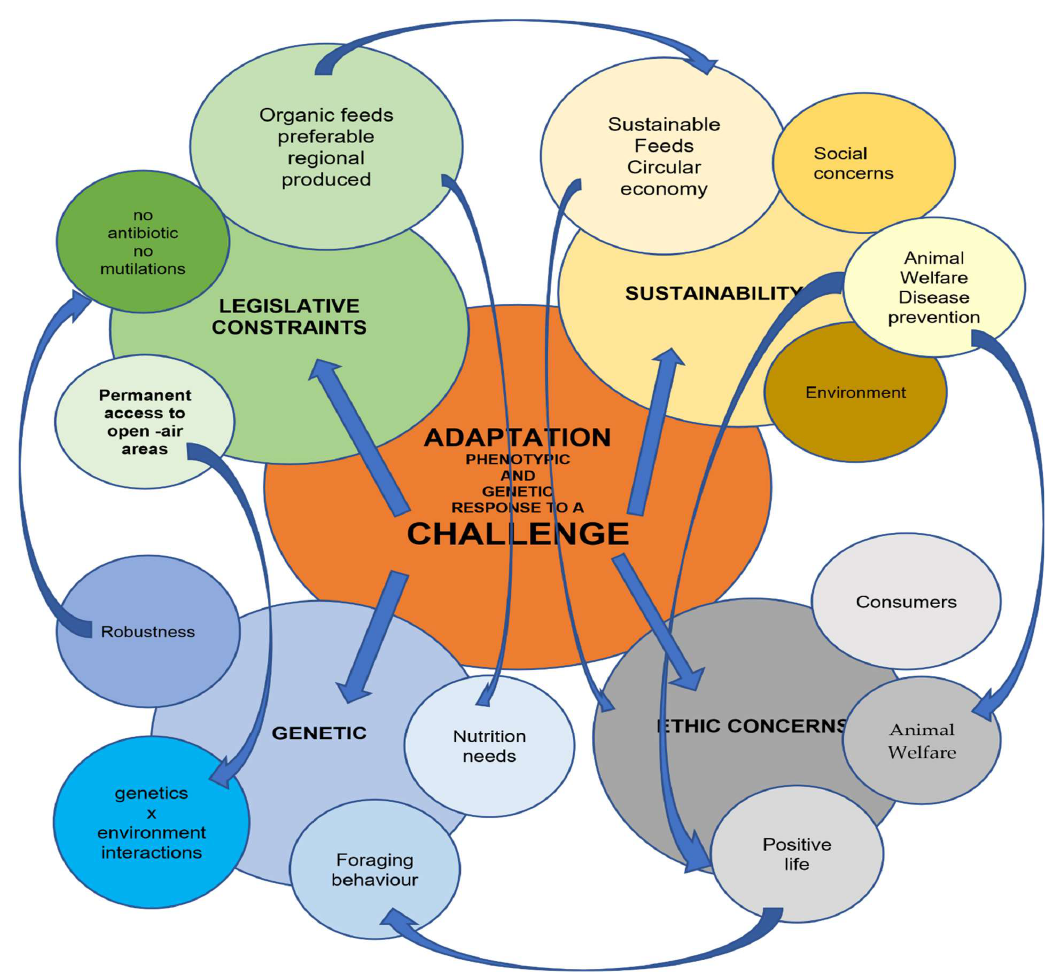
Figure 1. Conceptual map of the concept of adaptability.